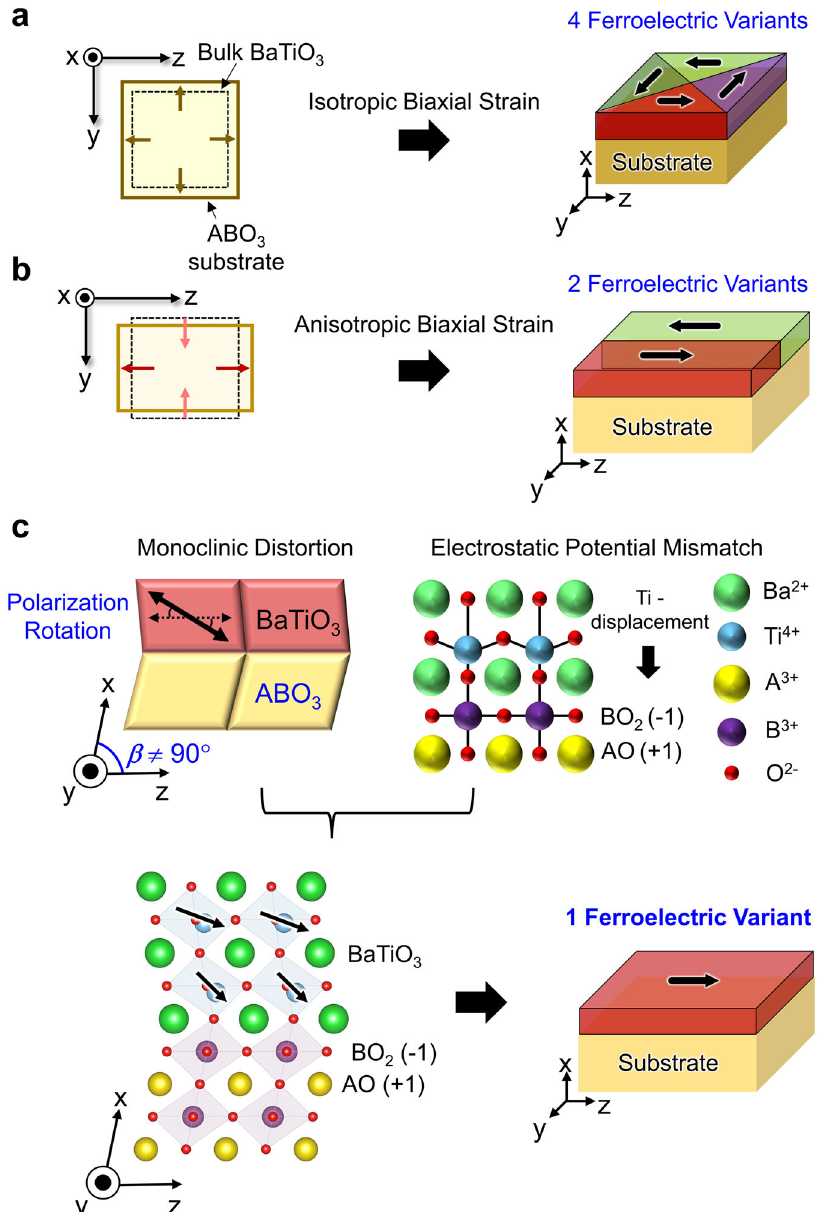
Fig. 1 Schematic diagram depicting the strategy employed to achieve single in-plane ferroelectric fi lm. a BTO fi lms grown under an isotropic biaxial tensile strain. x, y, and z correspond to the pseudocubic (pc) [100], [010], and [001] axes, respectively. Due to tensile strain, c -axis of BTO lies along the in-plane direction of the substrate. However, the isotropic geometry gives rise to form a multi-domain con fi guration where four ferroelectric variant exists. b In the case of the BTO fi lm grown under proper anisotropic biaxial strain, which is that the b pc and c pc of substrate are close to the a / b -axis and c -axis lattice parameters of tetragonal BTO, respectively, the BTO fi lm is expected to have a polarization direction parallel to z directions, resulting in two ferroelectric variants. c BTO fi lms grown on the substrate which possesses proper in-plane lattice match, monoclinic nature, and polar planes (e.g., BO 2 - terminated A 3 + B 3 + O 3 substrates), one of two con fi gurations can be stabilized. Note that the effect of electric fi eld generated by polar planes is weaker and weaker as far away from the interface, which results in a single ferroelectric variant along in-plane